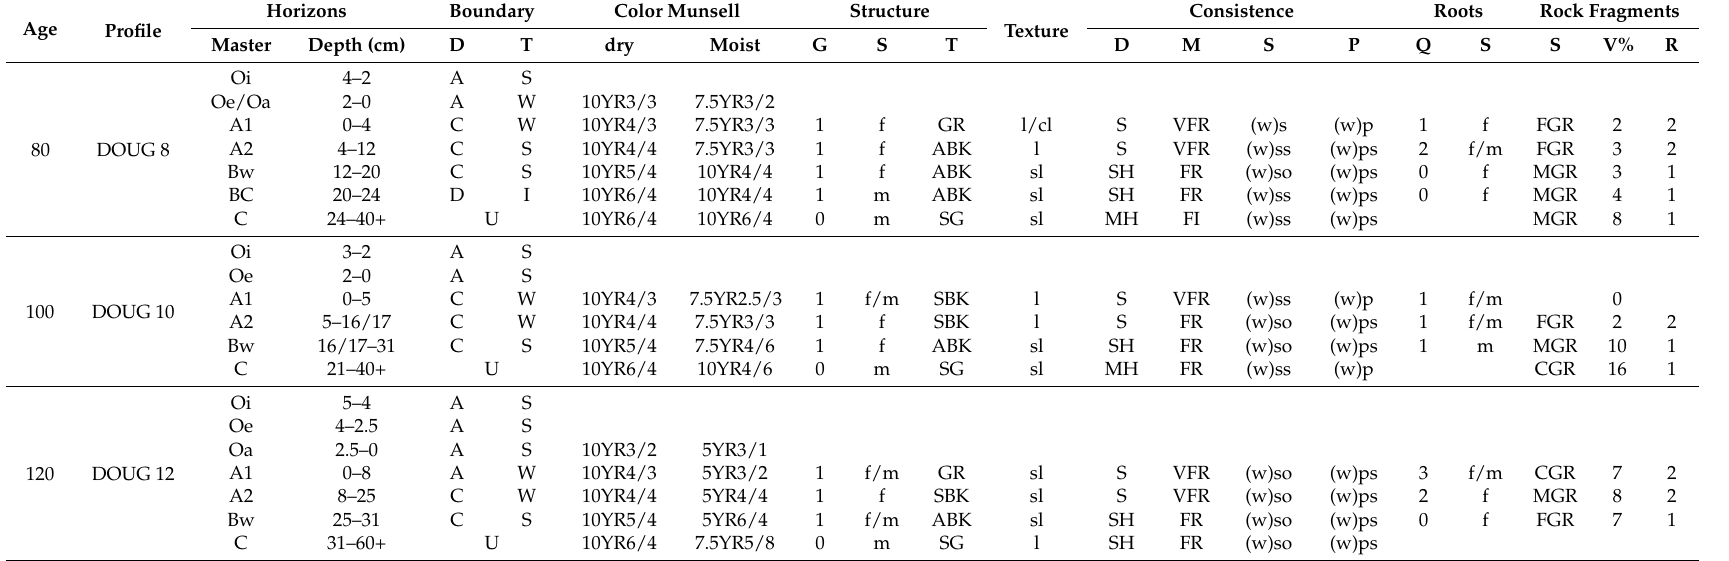
Table 1. Description of soil profiles according to Schoeneberger et al.